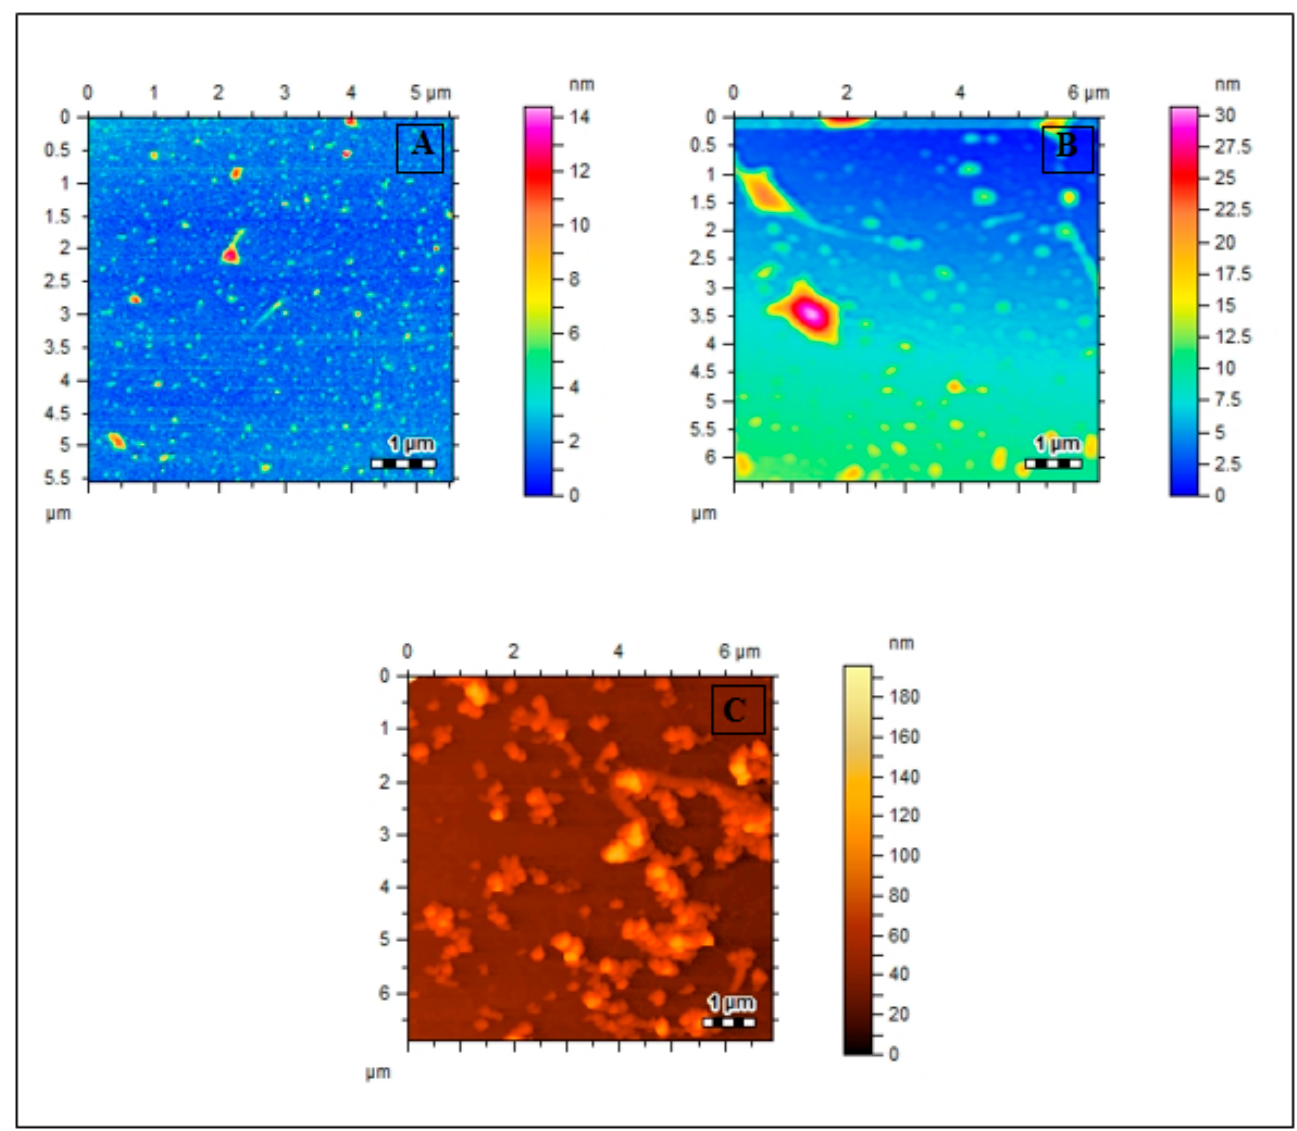
Figure 3. AFM images of ( A ) Met-Lip, ( B ) MOX-Met-Lip, ( C )